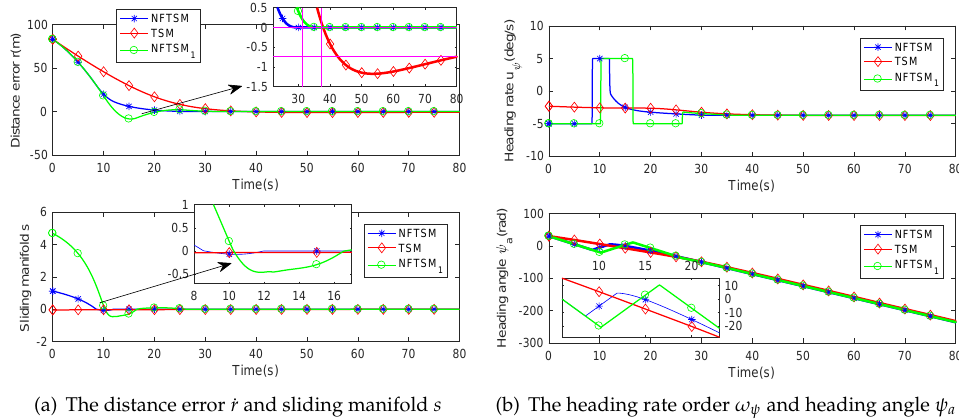
Figure 5. The results of tracking a stationary target with ψ a = 30 ◦